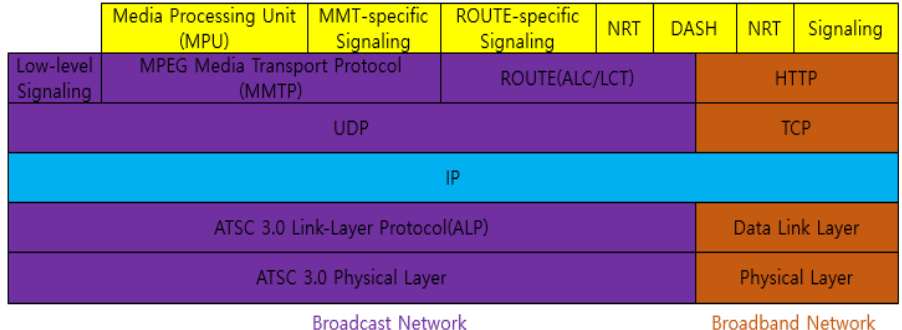
Figure 3. The radio protocol of the base station for 5G CBS.